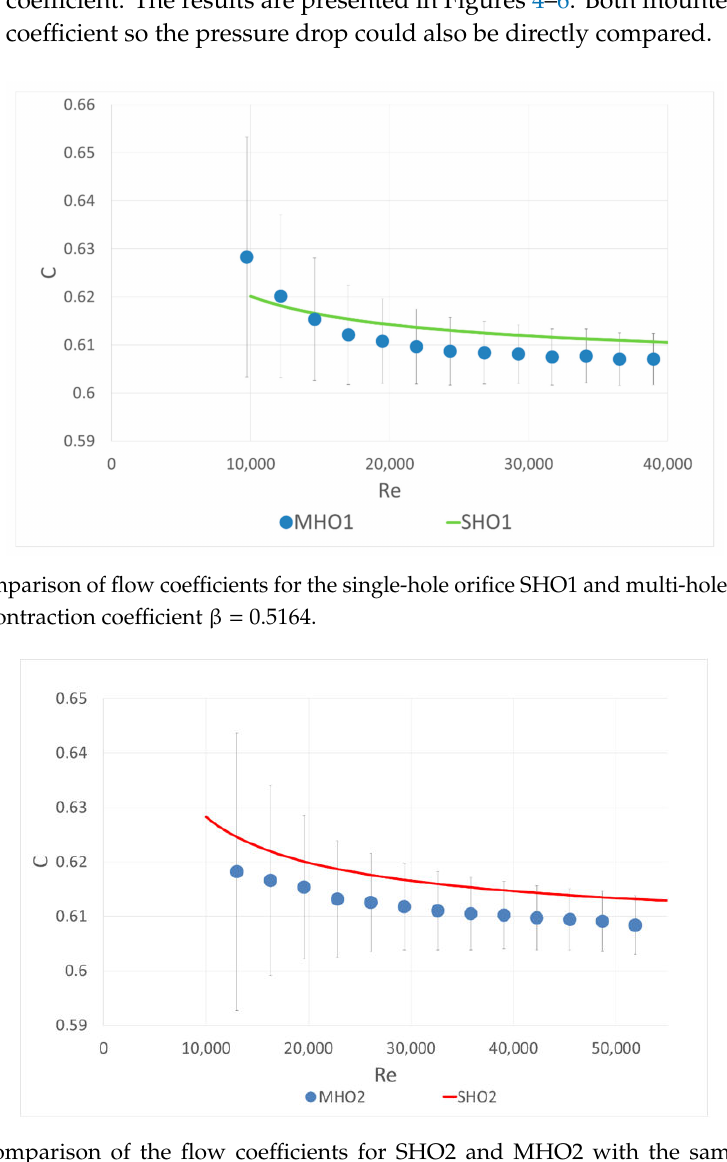
Figure 5. Comparison of the flow coe ffi cients for SHO2 and MHO2 with the same contraction coe ffi cient β =